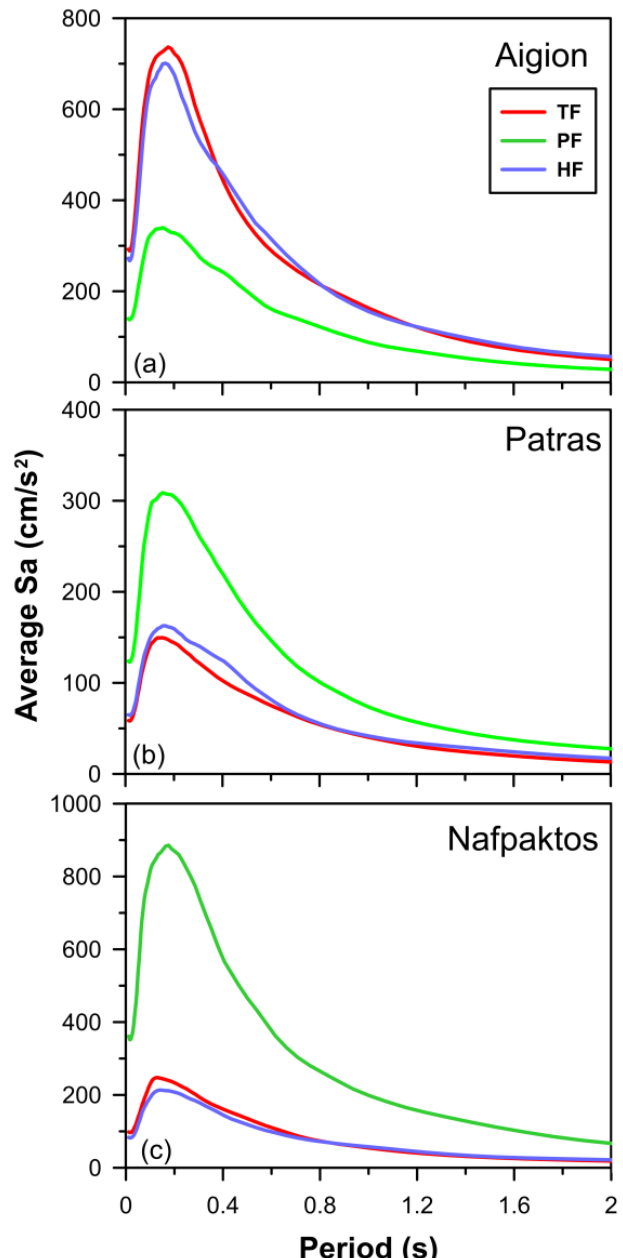
Figure 8. Response spectra of the selected earthquake scenarios for ( a ) Aigion, ( b ) Patras, and ( c ) Nafpaktos corresponding to 5% damping. TF: Trizonia Fault, HF: Helike Fault, PF: Psathopyrgos Fault.